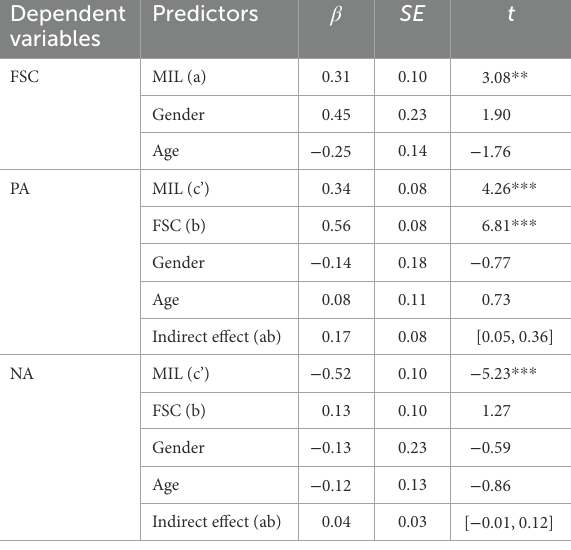
TABLE 4 Results of mediation